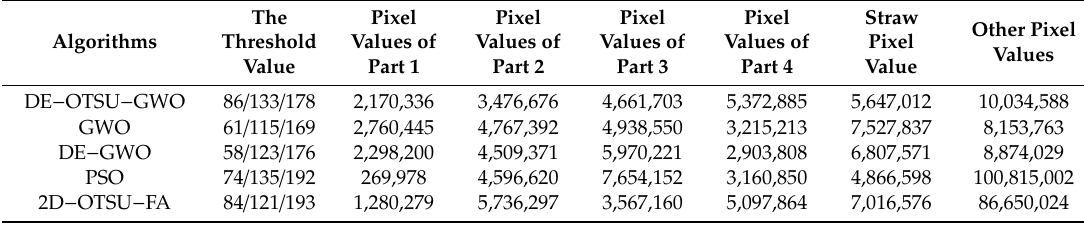
Table 6. The segmentation results of five algorithms.